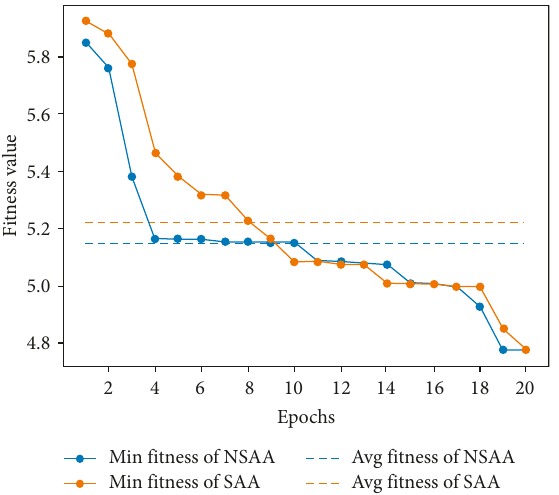
Figure 5: Comparing with NSAA and